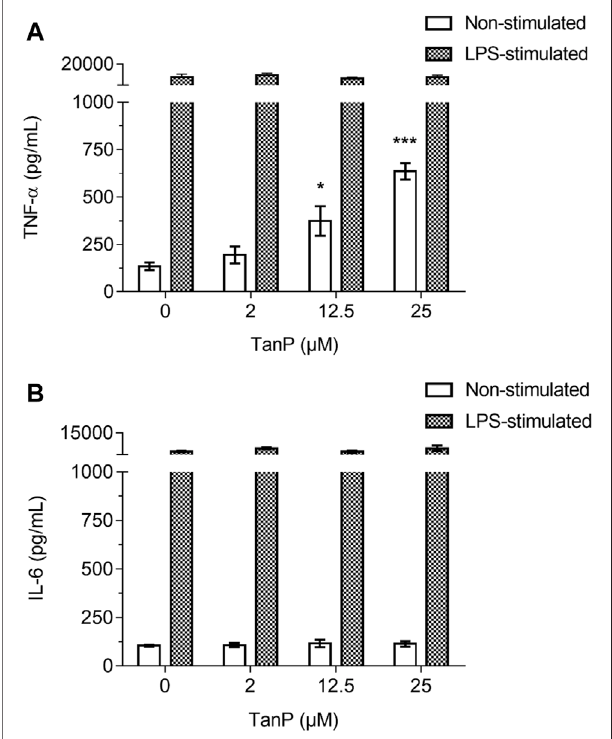
FIGURE 5 | Evaluation of TanP coagulant activity in vitro . (A) PT and (B) aPTTassays.Statisticalsigni fi cancewasperformedusingANOVAfollowedby Tukey ’ s test and expressed as mean ± SD (n (cid:2) 3). * p < 0.05, ** p < 0.01, and *** p < 0.001, compared with the negative control group (plasma without TanP).